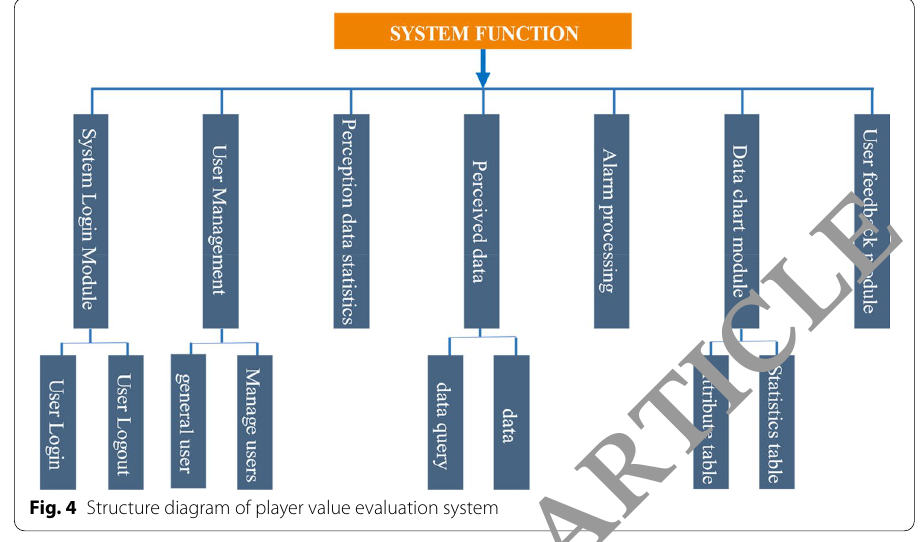
Fig. 4 Structure diagram of player value evaluation